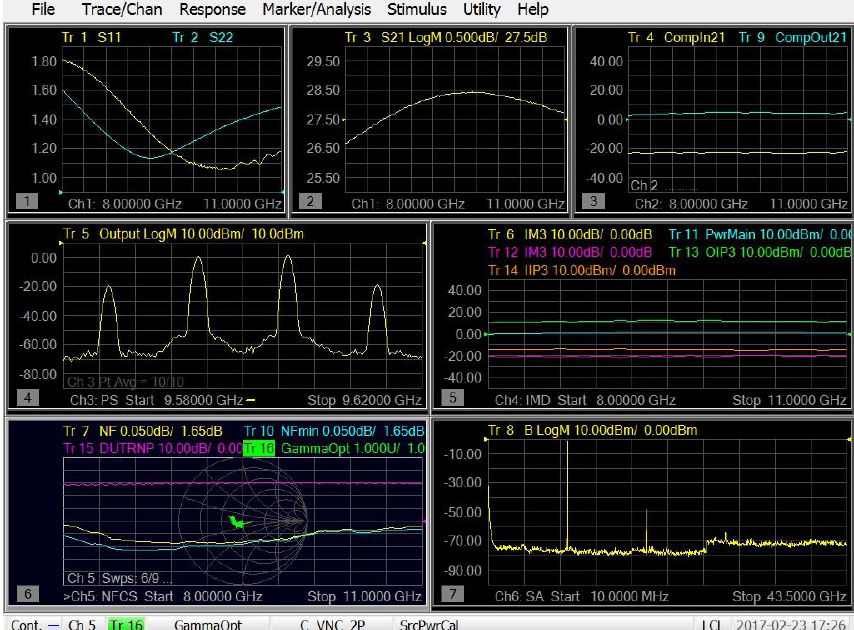
Figure 19. The screen of the VNA.